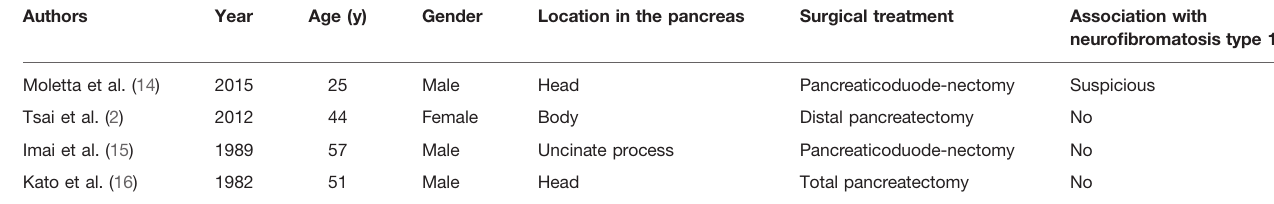
TABLE 1 | Clinical characteristics of neuro fi bromas in the